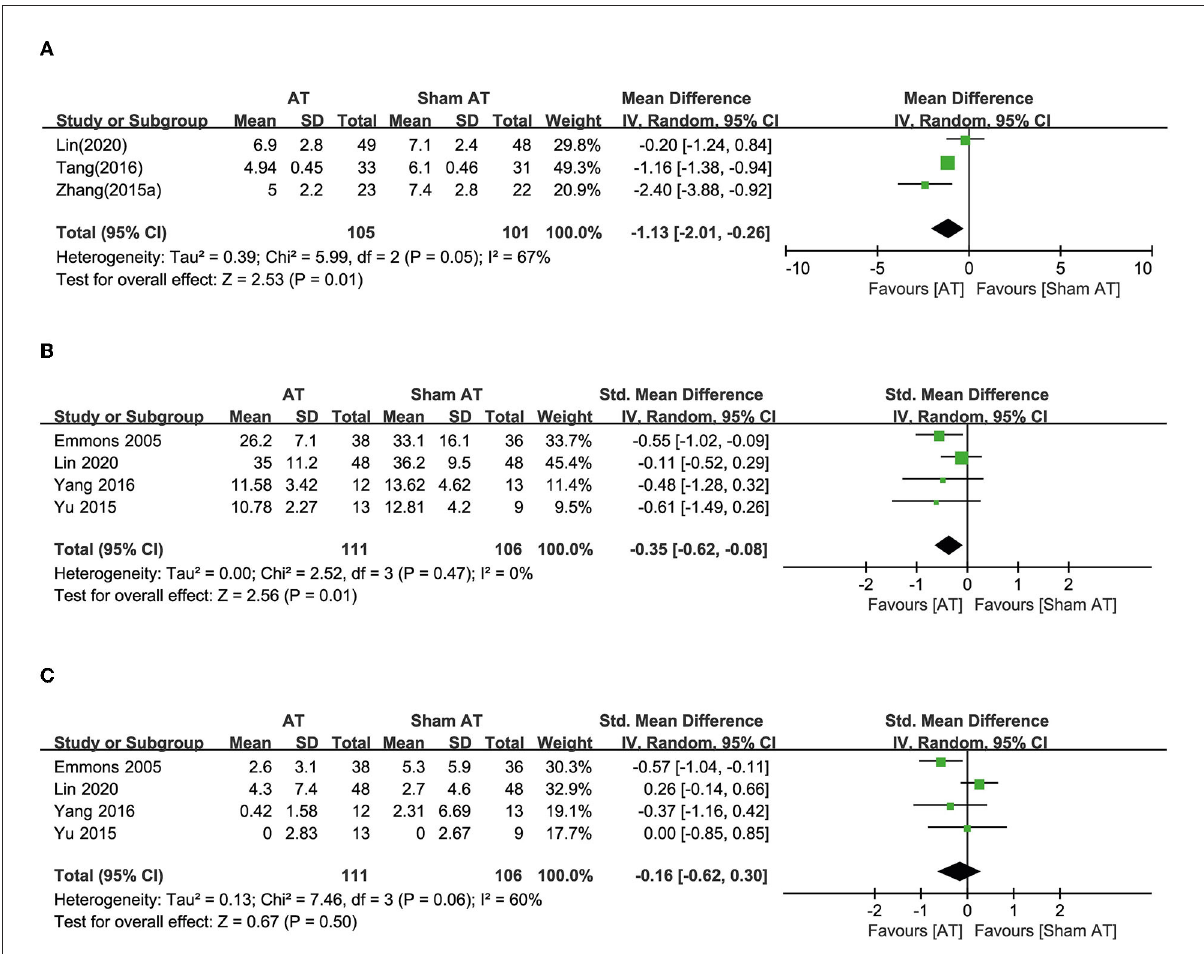
FIGURE3 Forest plot of (A) OABSS, (B) frequency, and (C) incontinence according to the comparison of AT vs. sham